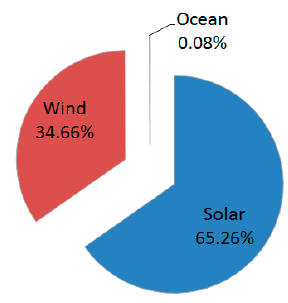
Figure 1. Contribution of wind, solar and ocean energy to the total renewable energy capacity installed worldwide at the end of 2015 [2,9].